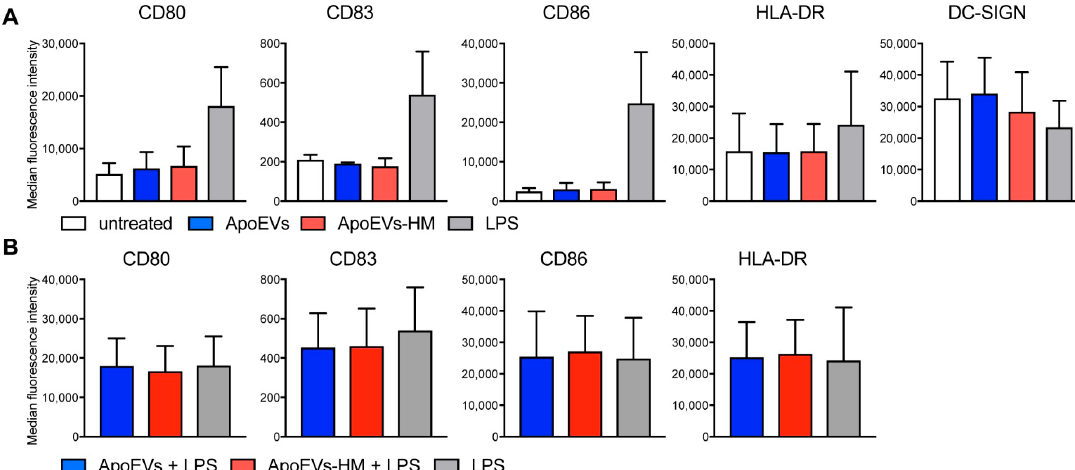
Figure 4. Glycan-modified ApoEVs (ApoEVs-HM) do not mature moDCs. ( A ) MoDCs were loaded with ApoEVs, ApoEVs-HM (100 μ g/mL (two donors) or 200 μ g/mL (two donors)), or LPS for 3 h, washed, and cultured o / n. The next day, the expression of maturation markers CD80, CD83, CD86, HLA-DR, and DC-SIGN was analyzed by flow cytometry. Graph is combined data of the four donors, showing mean + SD of the median fluorescence intensity. ( B ) MoDCs were loaded with ApoEVs, ApoEVs-HM (100 µ g / mL (two donors) or 200 µ g / mL (two donors)) in the presence of LPS (10 ng / mL) for 3 h. The next day, the expression of CD80, CD83, CD86, and HLA-DR was analyzed by flow cytometry. Graph is combined data of the four donors, showing mean + SD of the median fluorescence intensity.